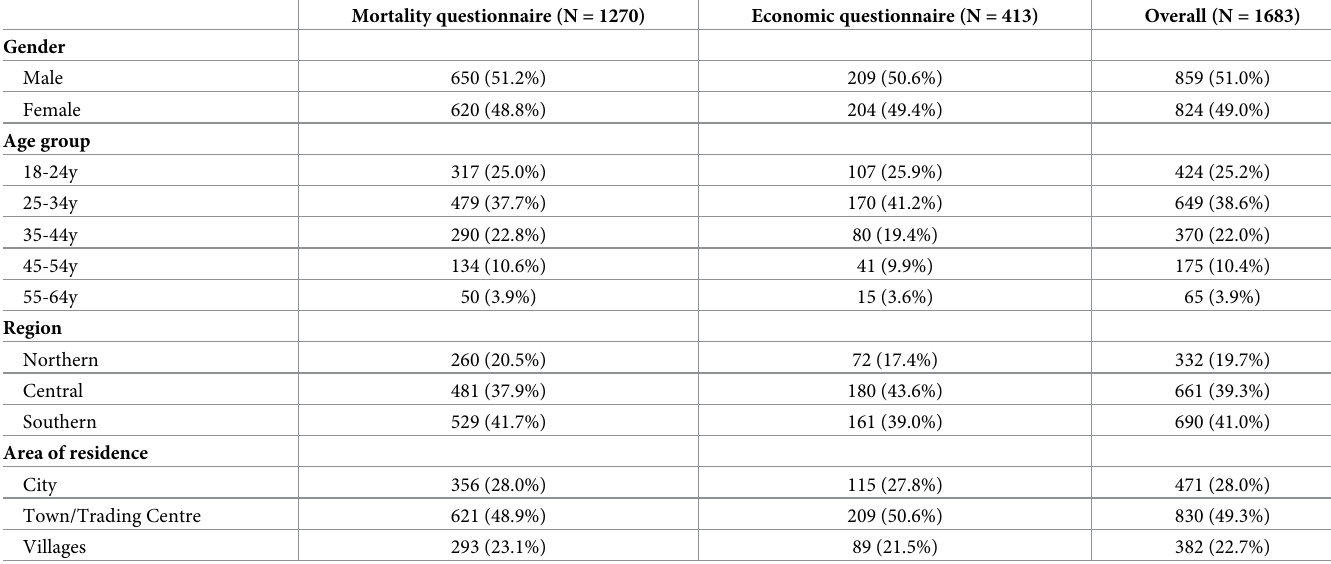
Table 1. Characteristics of study participants, by study